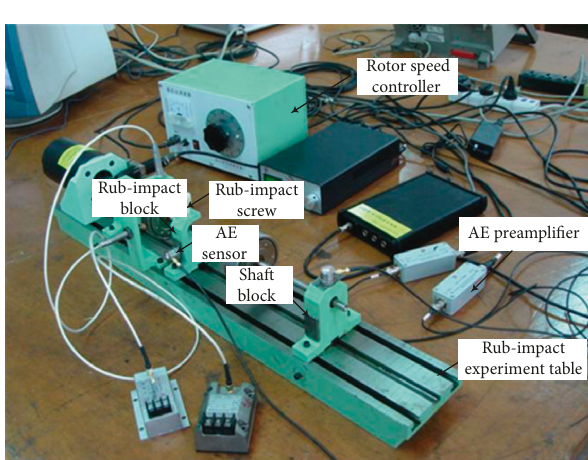
Figure 3: Rubbing AE in rotary machine experiment.